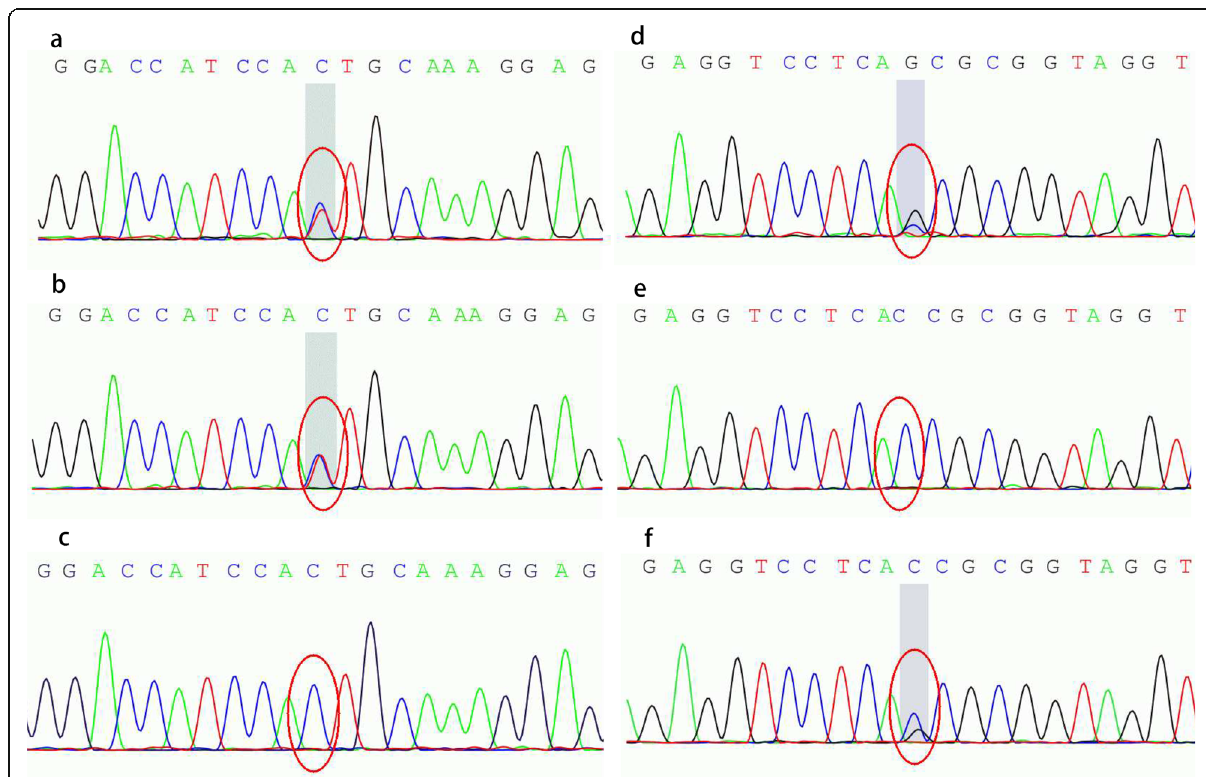
Fig. 1 Sanger sequencing results show mutations in DGAT1 detected in the proband ’ s family. a Chromatogram showing the proband with a heterozygous mutation at chr8:145541376, c.895-1G > A. b Chromatogram showing the proband ’ s father carrying the same heterozygous mutation, c.895-1G > A. c Chromatogram showing the proband ’ s mother with no mutation at this site. d Chromatogram showing the proband with another heterozygous mutation at chr8:145541757, c.751 + 1G > C. e Chromatogram showing the proband ’ s father with no mutation at this site. f Chromatogram showing the proband ’ s mother carrying the same heterozygous mutation, c.751 + 1G > C